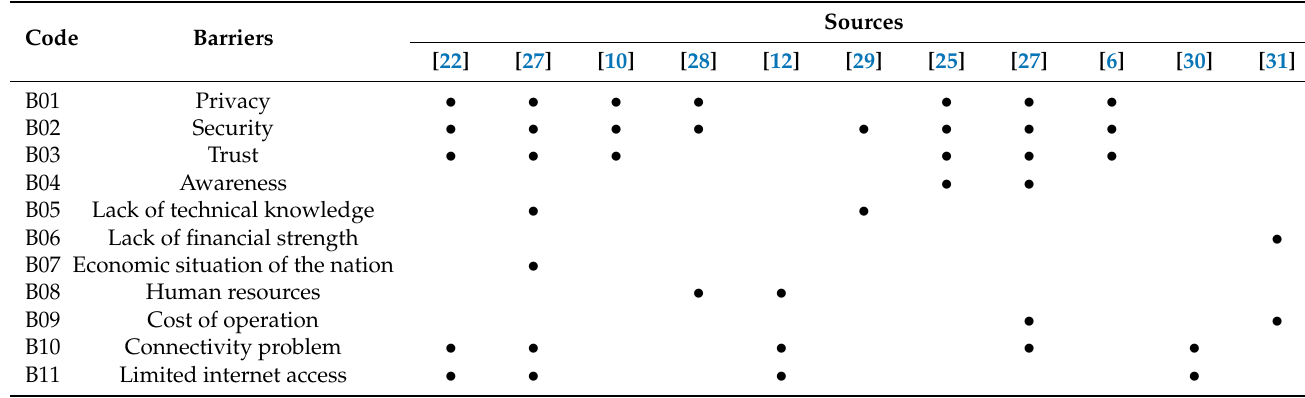
Table 1. Barriers to the application of